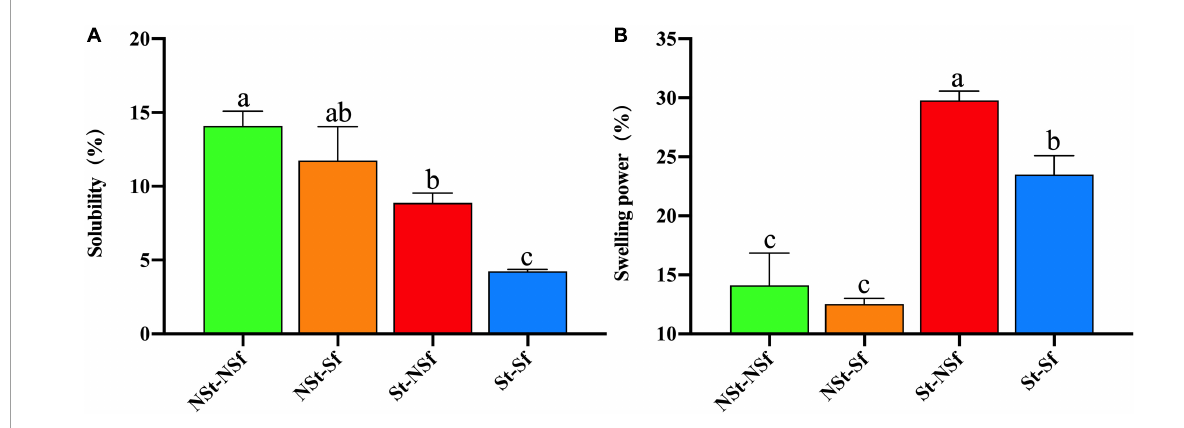
FIGURE4 Effect of steaming and sulfur fumigation on solubility (A) and swelling power (B) of Gastrodia elata starch.